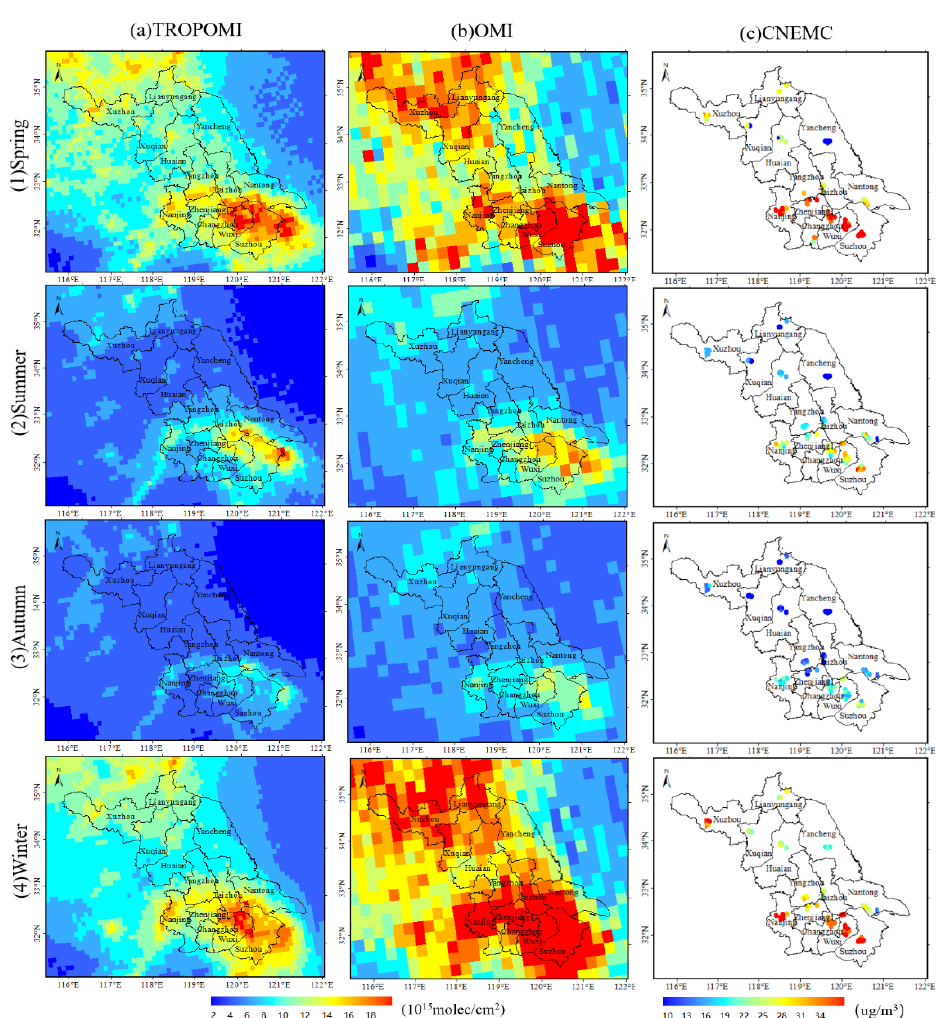
Figure 2. Seasonal averaged NO 2 in (1) spring, (2) summer, (3) autumn and (4) winter over Jiangsu from the ( a ) TROPOMI, ( b ) OMI and ( c ) CNEMC .